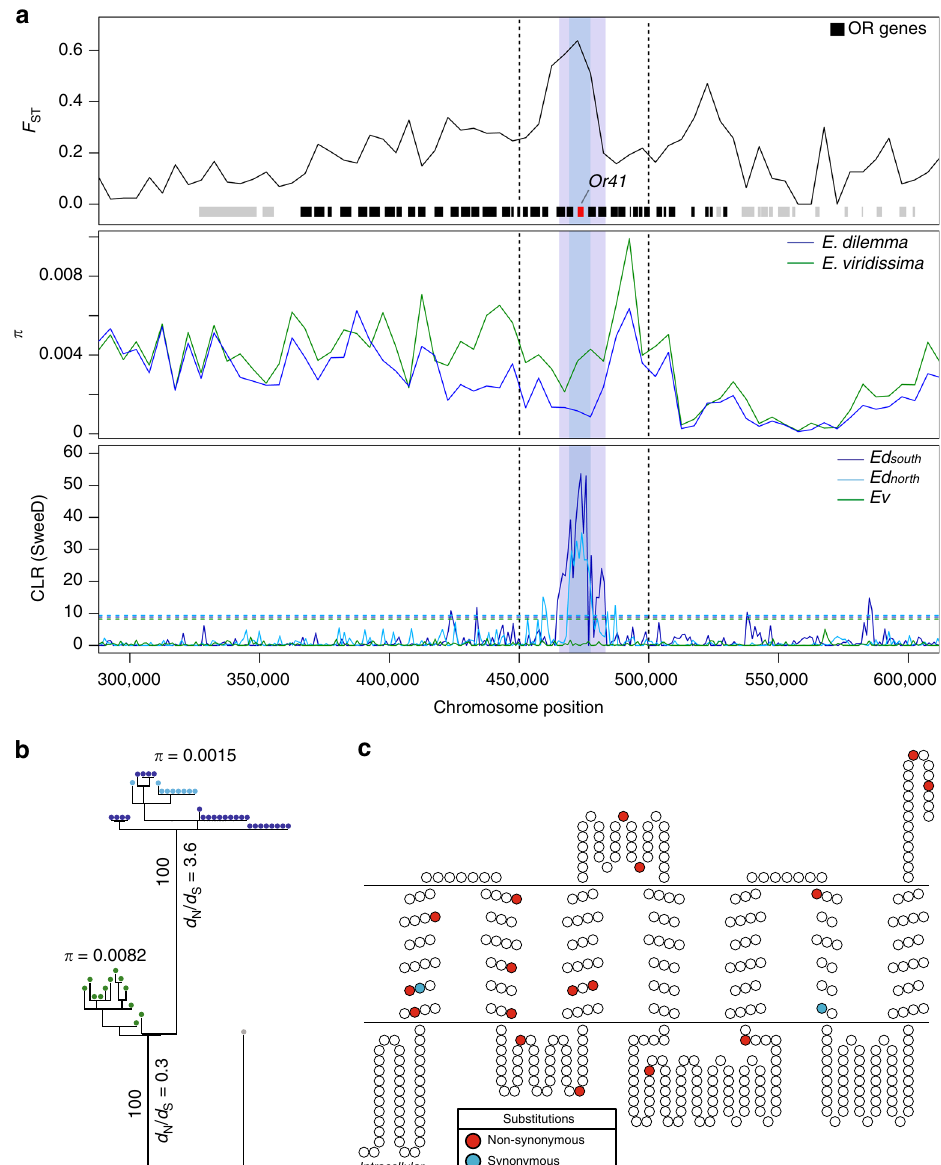
Fig. 3 Odorant receptor (OR) gene Or41 evolved through a species-speci fi c selective sweep. a The only E. dilemma -speci fi c selective sweep identi fi ed was located within an F ST outlier window (dashed lines) overlapping with a high interspeci fi c difference in π within a tandem array containing 39 OR genes on scaffold_61 (green: E. viridissima ; intermediate blue: E. dilemma ). High composite likelihood ratios (CLR, bottom) in Ed north (light blue) and Ed south (dark blue) but not in Ev (green) indicate a selective sweep shared by both E. dilemma lineages that overlap with Or41 in the center (shaded regions). Horizontal dashed lines in the CLR panel indicate signi fi cance threshold for each lineage as indicated in the respective colors. b A maximum likelihood phylogeny of Or41 ( n = 47 individuals) demonstrates that genotypes are species-speci fi c. π was fi ve times lower in E. dilemma in comparison with E. viridissima . A d N / d S analysis of species-speci fi c genotypes with fi ve outgroup species (gray dot) indicates positive selection on the E. dilemma branch ( d N / d S = 3.6), but purifying selection of the ancestral genotype in E. viridissima ( d N / d S = 0.3). Bootstrap support for tested branches is indicated. Color code as in a . c Seventeen of 19 substitutions mapped on the predicted membrane topology of the Or41 protein were non-synonymous (red), whereas 2 were synonymous